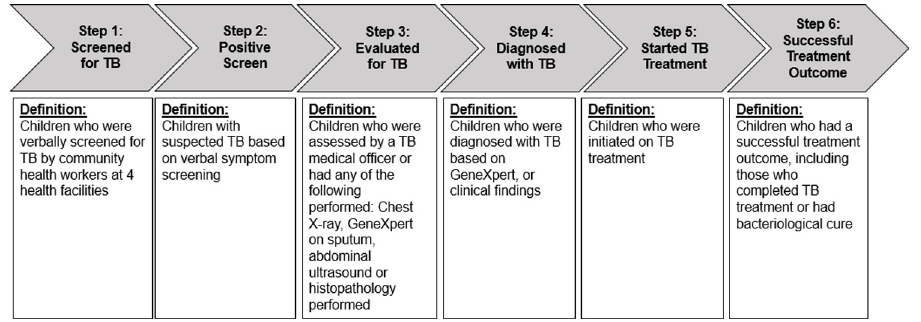
Fig 2. Steps in the childhood tuberculosis care cascade from screening to treatment